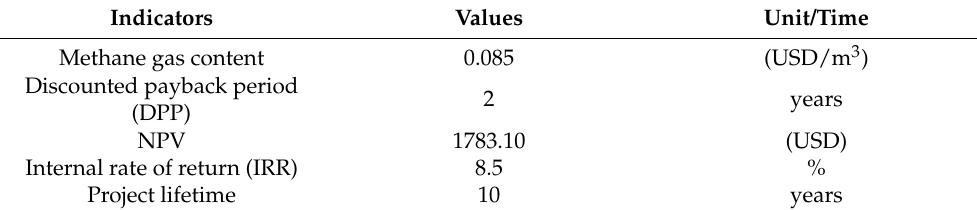
Table 8. Discounted payback period with the NPV and IRR on methane